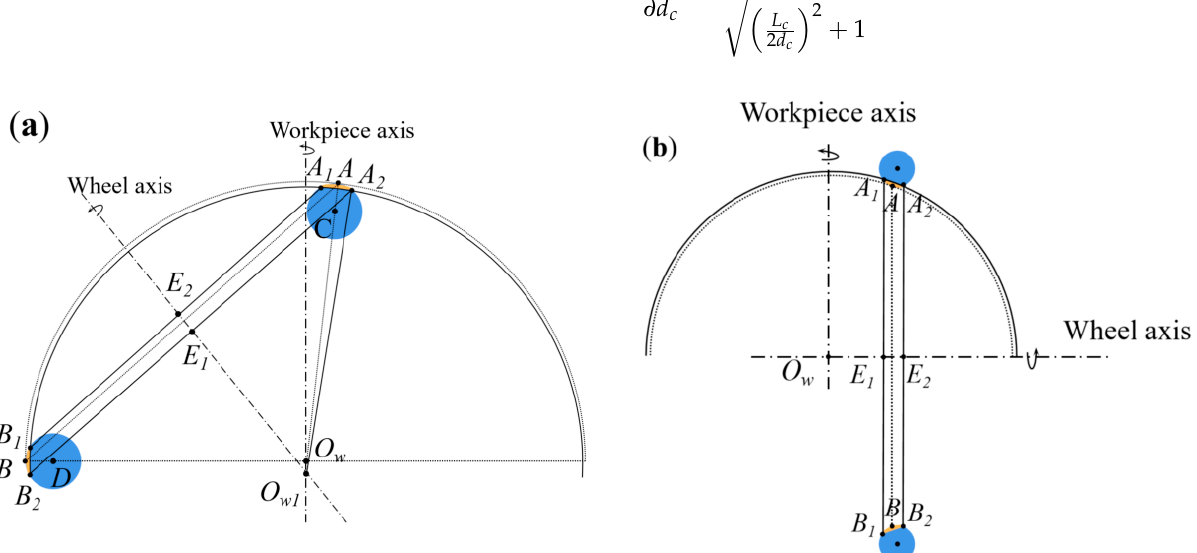
Figure 7. Geometric model of grinding wheel wear: ( a ) inner sphere machining wear; ( b ) outer sphere machining wear.